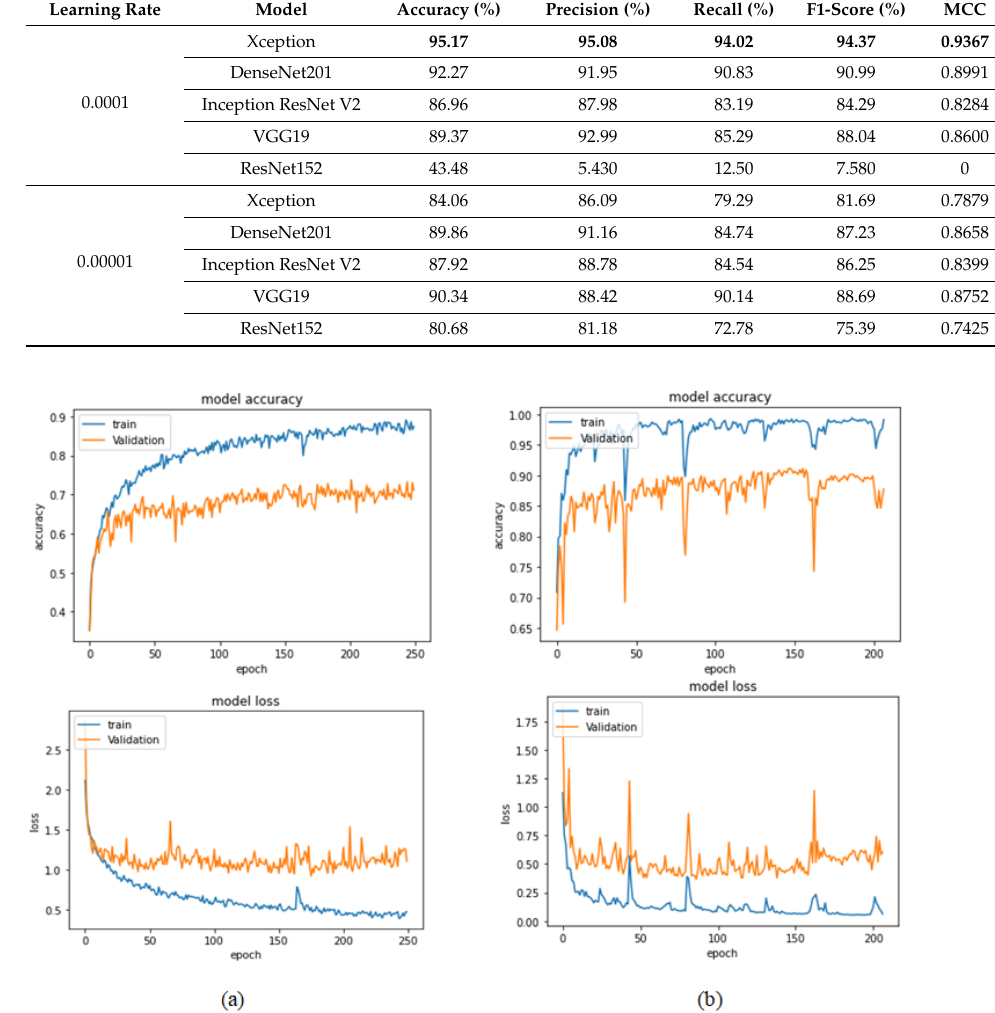
Figure 25. Learning curves for Xception at 0.0001 learning rate in 100× magnification-dependent multi-classification ( a ) Accuracy and loss curves of Phase 1 of training. ( b ) Accuracy and loss curves of Phase 2 of training.